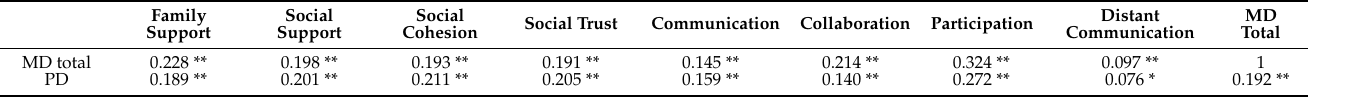
Table 2. Correlations between Mediterranean diet, psychological distress, and social capital in young